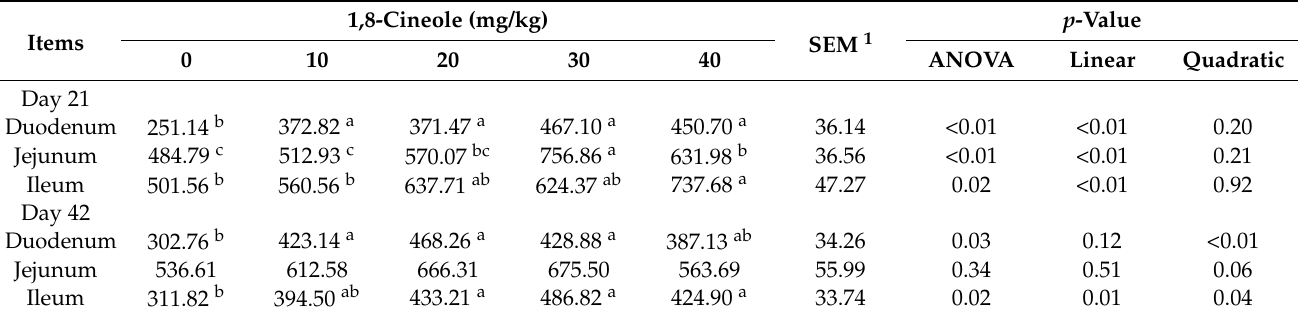
Table 7. Effects of dietary 1,8-cineole supplementation on intestinal mucosa SIgA(ng/mg) content of broiler chickens.